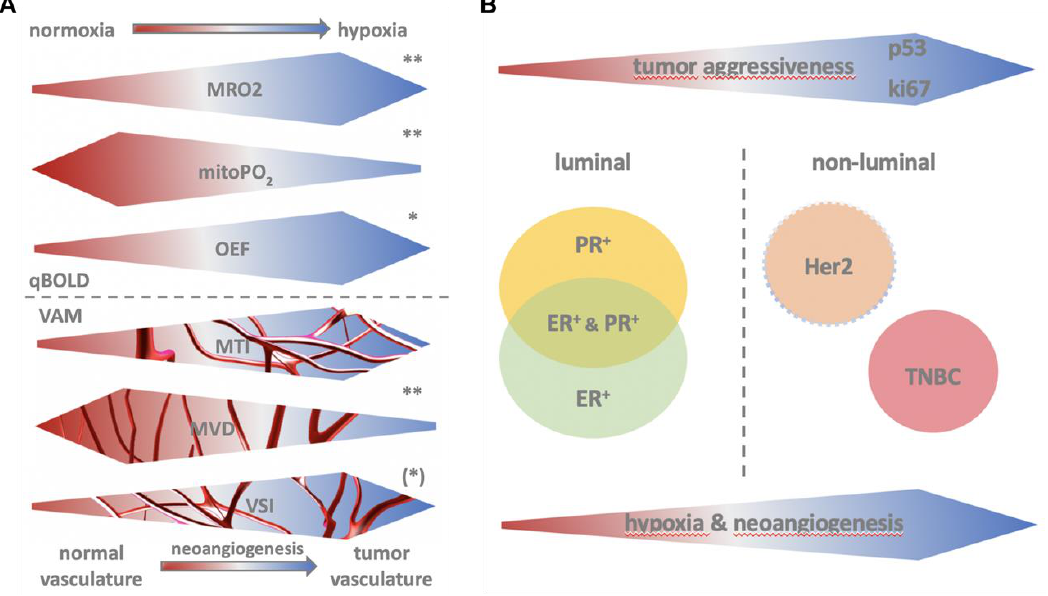
Figure 6. Panel A . Illustration of imaging marker behavior in relation to hypoxia and neoangiogenesis. Direction of arrow indicates increase or decrease of values. Asterisks indicate predictive significance as suggested by our data (** highly indicative, * moderately indicative, (*) mildly indicative, schematically based on data derived from Spearman’s rank correlation coefficient analysis). Panel B . Schematic illustration of biomarker distribution in relation to hypoxia, neoangiogenesis, and tumor aggressiveness. Triple negative breast cancer (TNBC).